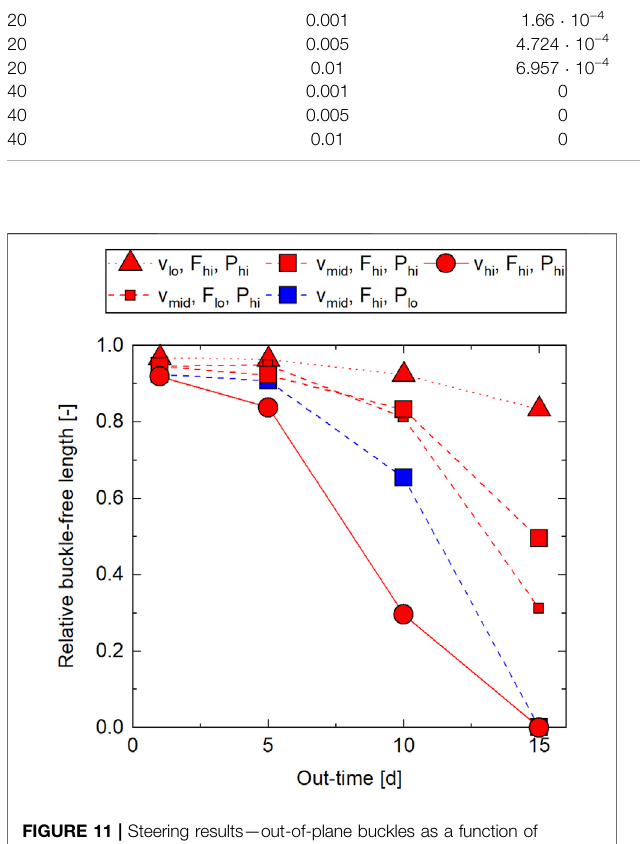
FIGURE 11 | Steering results — out-of-plane buckles as a function of out-time from AFP lay-up experiments at steering radius R (cid:1) 600 mm (Material: IM7/8552 prepreg; out-time: 1 day – 15 days at T (cid:1) 21 ° C , RH (cid:1) 40 % ; v lo (cid:1) 0 . 03 m / s , v mid (cid:1) 0 . 06 m / s , v hi (cid:1) 0 . 1 m / s , F lo (cid:1) 200 N , F hi (cid:1) 400 N , P lo (cid:1) 150 W , P hi (cid:1) 350 W ).